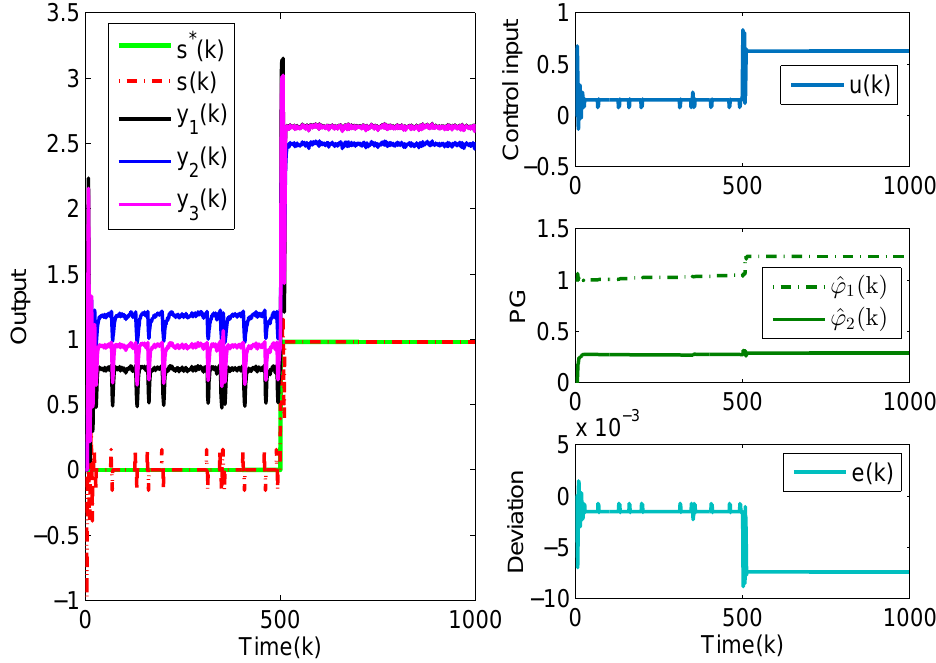
Figure 6. The curves of PG estimation values, control input, deviation, and outputs with l =